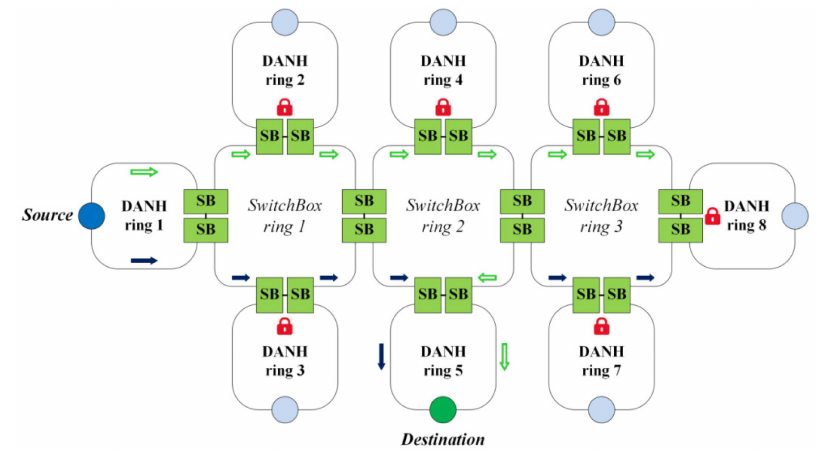
Figure 21. Network unicast traffic under SwitchBox-based